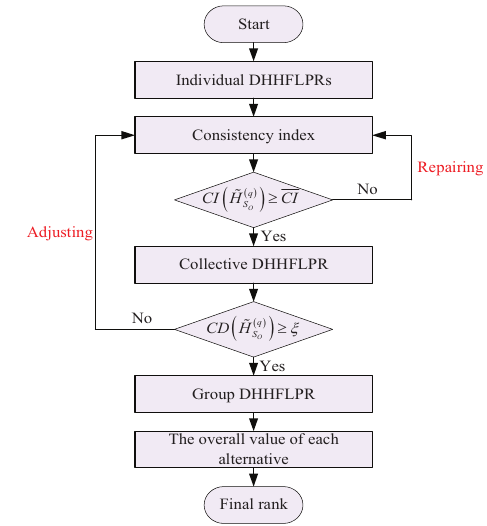
Figure 4. The flowchart of the multiplicative consistency and consensus-based decision-making